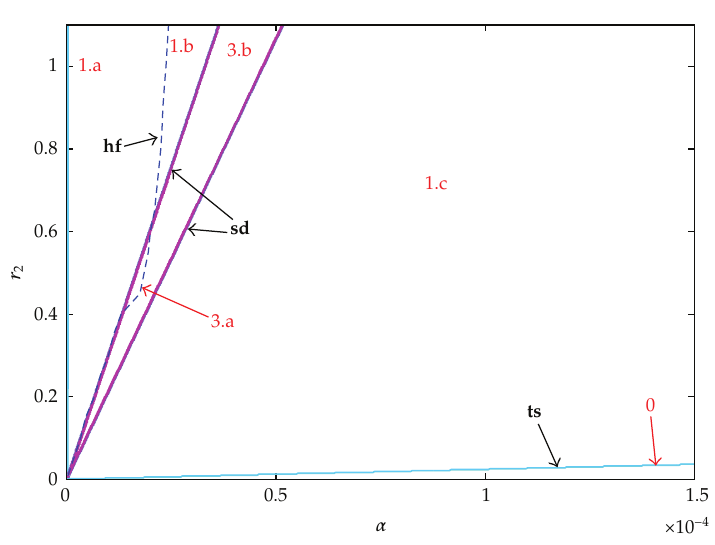
Figure 5: The two-dimensional transition structure as a function of α (cid:4) the tumor cell is predated by e ff ector cells rate (cid:5) and r 2 (cid:4) the maximal growth rate of the tumor cells population (cid:5) : sd is the saddle node bifurcation, ts is the transcritical bifurcation, and hf is the supercritical Hopf bifurcation. (cid:4) Immunotherapy with both ACI and IL-2 Case; see Table 1 and s 1 (cid:8) 40, s 2 (cid:8) 10. (cid:5)